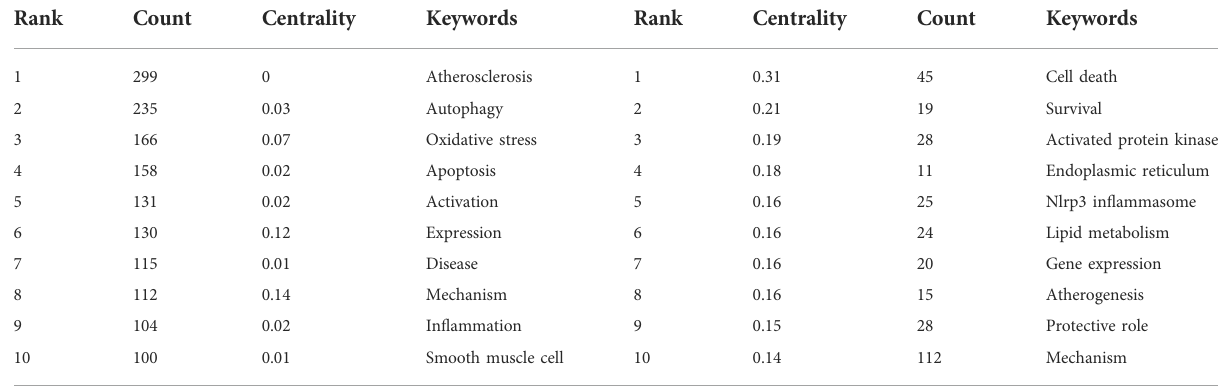
TABLE 5 Top 10 keywords in terms of publications and centrality. Rank